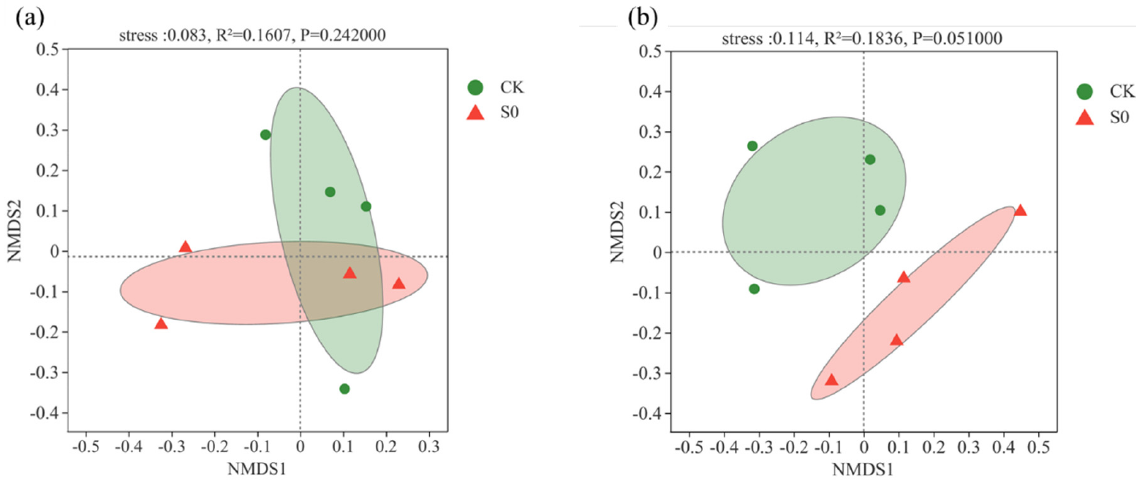
Figure 2. Non-metric multidimensional scaling (NMDS) of bacterial community composition ( a ) and fungal community composition ( b ) at the ASV level in control (CK) and snow exclusion (S0) plots the spring snow melting period.